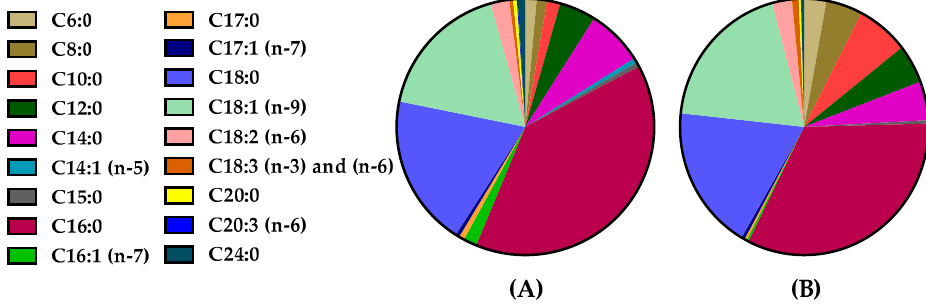
Figure 3. Free fatty acid average content in cow milk ( A ) and goat milk ( B ).